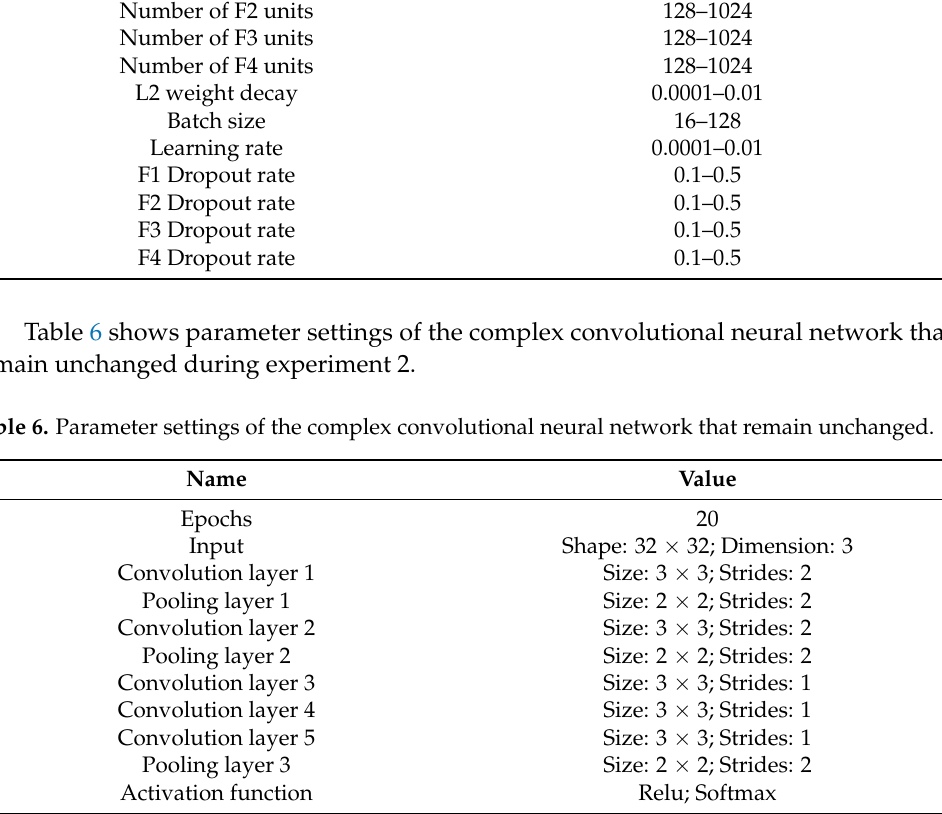
Figure 6. Five Flowers dataset example. Table 5. The range of hyperparameters to be optimized on Five Flowers.